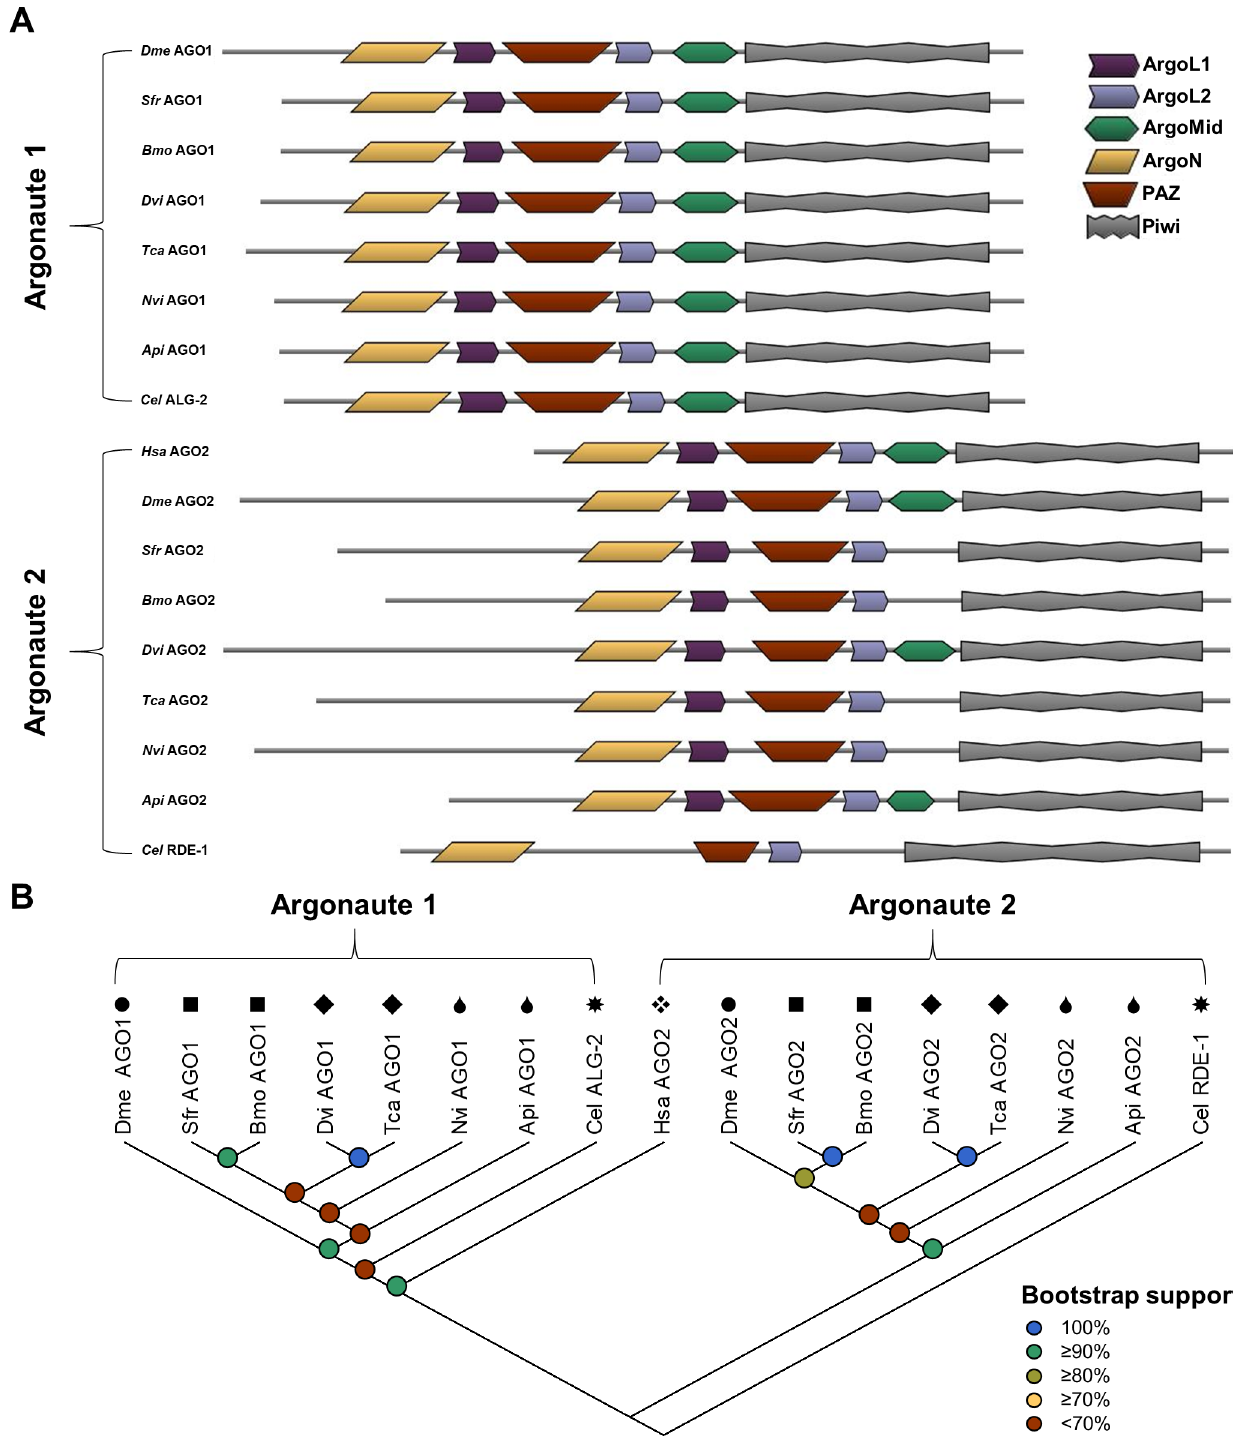
Fig 3. Properties of core mi- and siRNA pathway argonaute proteins in WCR, FAW, and SGSB. (A) The predicted protein domains encoded by the AGO1-PC and AGO2-PB transcripts of A . pisum ( Api : XP_003240620.1, XM_001944817.3), B . mori ( Bmo : BAF73719.1, XP_012548543.1), C . elegans ( Cel : NP_871992.1, NP_741611.1), D . melanogaster ( Dme :NP_001246314.1, NP_730054.1), D . virgifera virgifera (WCR– Dvi :MG225424, MG225426), H . sapiens ( Hsa : NP_036286.2), N . viridula (SGSB– Nvi : MG225455, MG225456), S . frugiperda (FAW– Sfr :MG225441, MG225443), and T . castaneum ( Tca : XP_015837987.1, XP_008192985.1). Predicted domains include an ArgoN (PF16486), an ArgoL1 (PF08699), a PAZ (PF02170), an ArgoL2 (PF16488), an ArgoMid (PF16487), and a Piwi (PF02171). E-values for domains predicted in WCR, FAW, and SGSB range from 1.1×10 − 8 to 1.6×10 − 110 . (B)